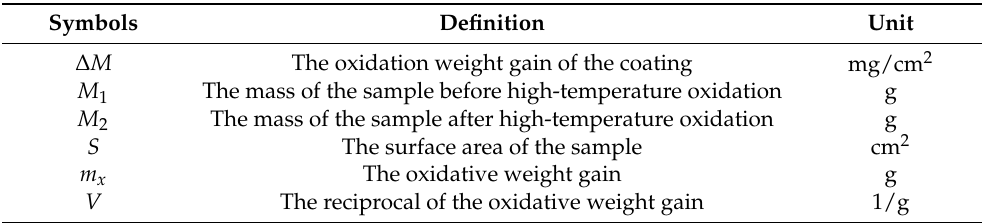
Table A1. Model Inputs and